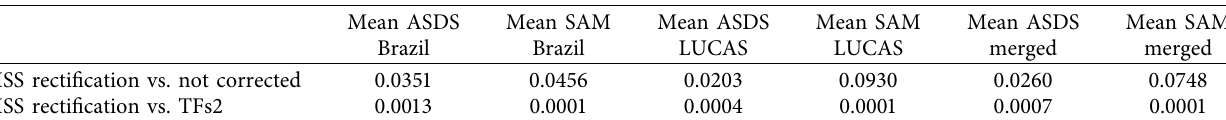
ISS rectifcation vs. not